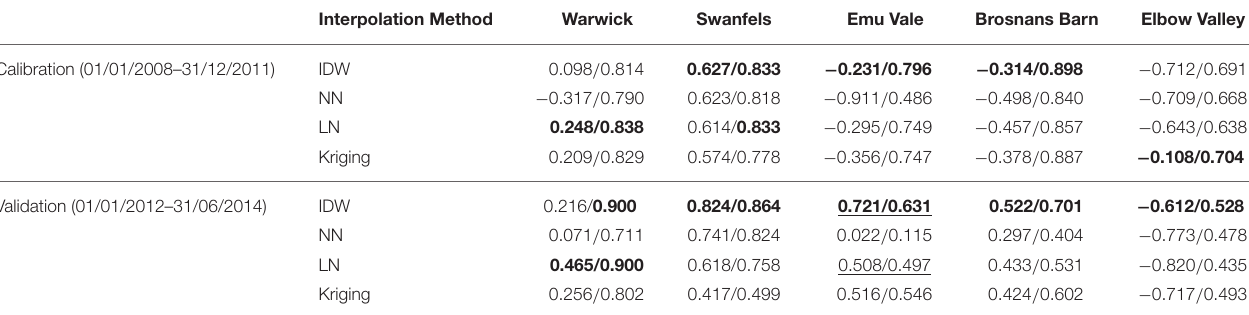
The bold numbers indicate the best performance among different interpolation methods at each station. The values underlined indicate the quality control degraded the streamflow simulation in terms of NSE.